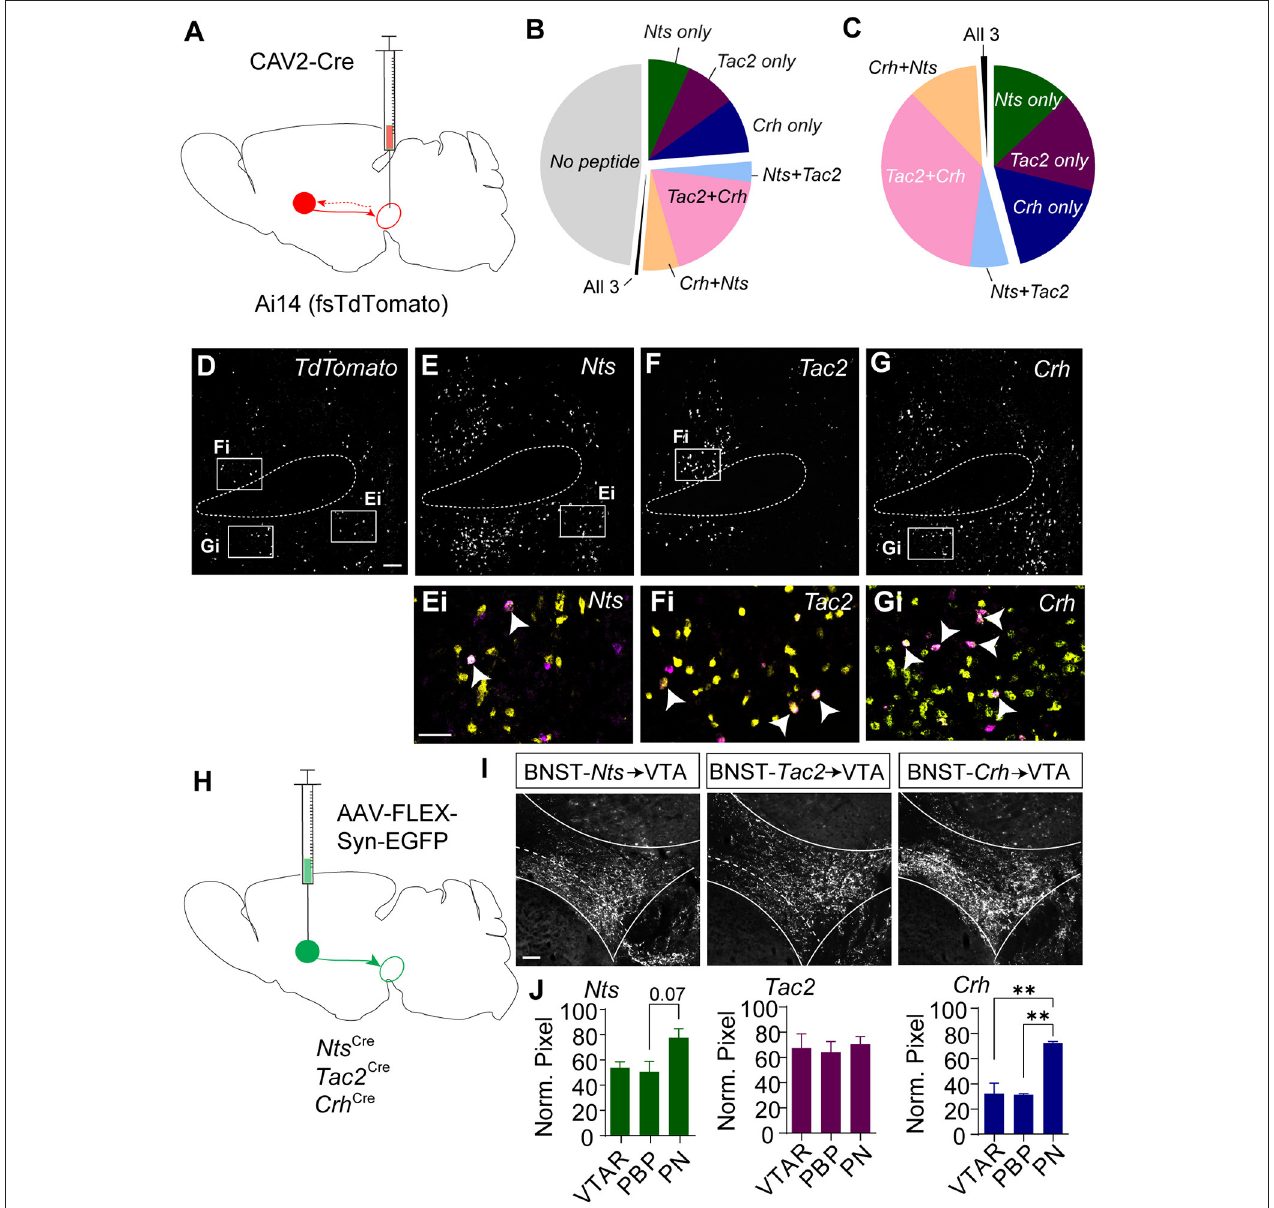
FIGURE 3 | Retrograde and anterograde labeling of BNST to VTA Nts, Tac2 , and Crh projections. (A) Schematic of CAV2-Cre injection into the VTA of an Ai14 (floxed-stop TdTomato) mouse to label VTA-projecting neurons. In situ hybridization was performed on BNST sections to probe for TdTomato , Crh , Tac2 , and Nts . (B) Pie chart showing peptide expression in VTA-projecting TdTomato-positive neurons in the BNST ( n = 776 total neurons from N = 7 mice). (C) Peptide distribution in VTA-projecting BNST neurons that expressed at least one peptide ( n = 402 neurons from N = 7 mice). (D–G) Example image showing in situ for TdTomato (D) , Nts (E) , Tac2 (F) , and Crh (G) . Scale bar = 100 µ m. Ei-Gi are zoomed in views showing overlap of peptide markers (yellow) and TdTomato (magenta) and correspond to boxed regions in (E–G) . and indicated peptide (yellow). Scale bar = 50 µ m. All images are of the same brain section, separated by peptide for ease of viewing. White arrows identify TdTomato-positive neurons labeled with a single peptide. (H) Schematic of injection of AAV-FLEX-synaptophysin-EGFP for BNST to VTA terminal mapping. (I) Example images of syn-EGFP labeling in the VTA in each Cre line. Scale bar = 100 µ m. (J) Normalized pixel intensity in each VTA subregion [VTAR = rostral VTA, PBP = parabrachial pigmented nucleus, PN = paranigral VTA; N = 3 mice/group, One-way ANOVA Nts: F (2,6) = 4.522, P = 0.0634, Tukey’s multiple comparisons PBP vs. PN P = 0.0747, Crh: F (2,6) = 22.69, P = 0.0016, Tukey’s multiple comparisons ** P < 0.01]. Data in bar graphs are presented as mean ± SEM.